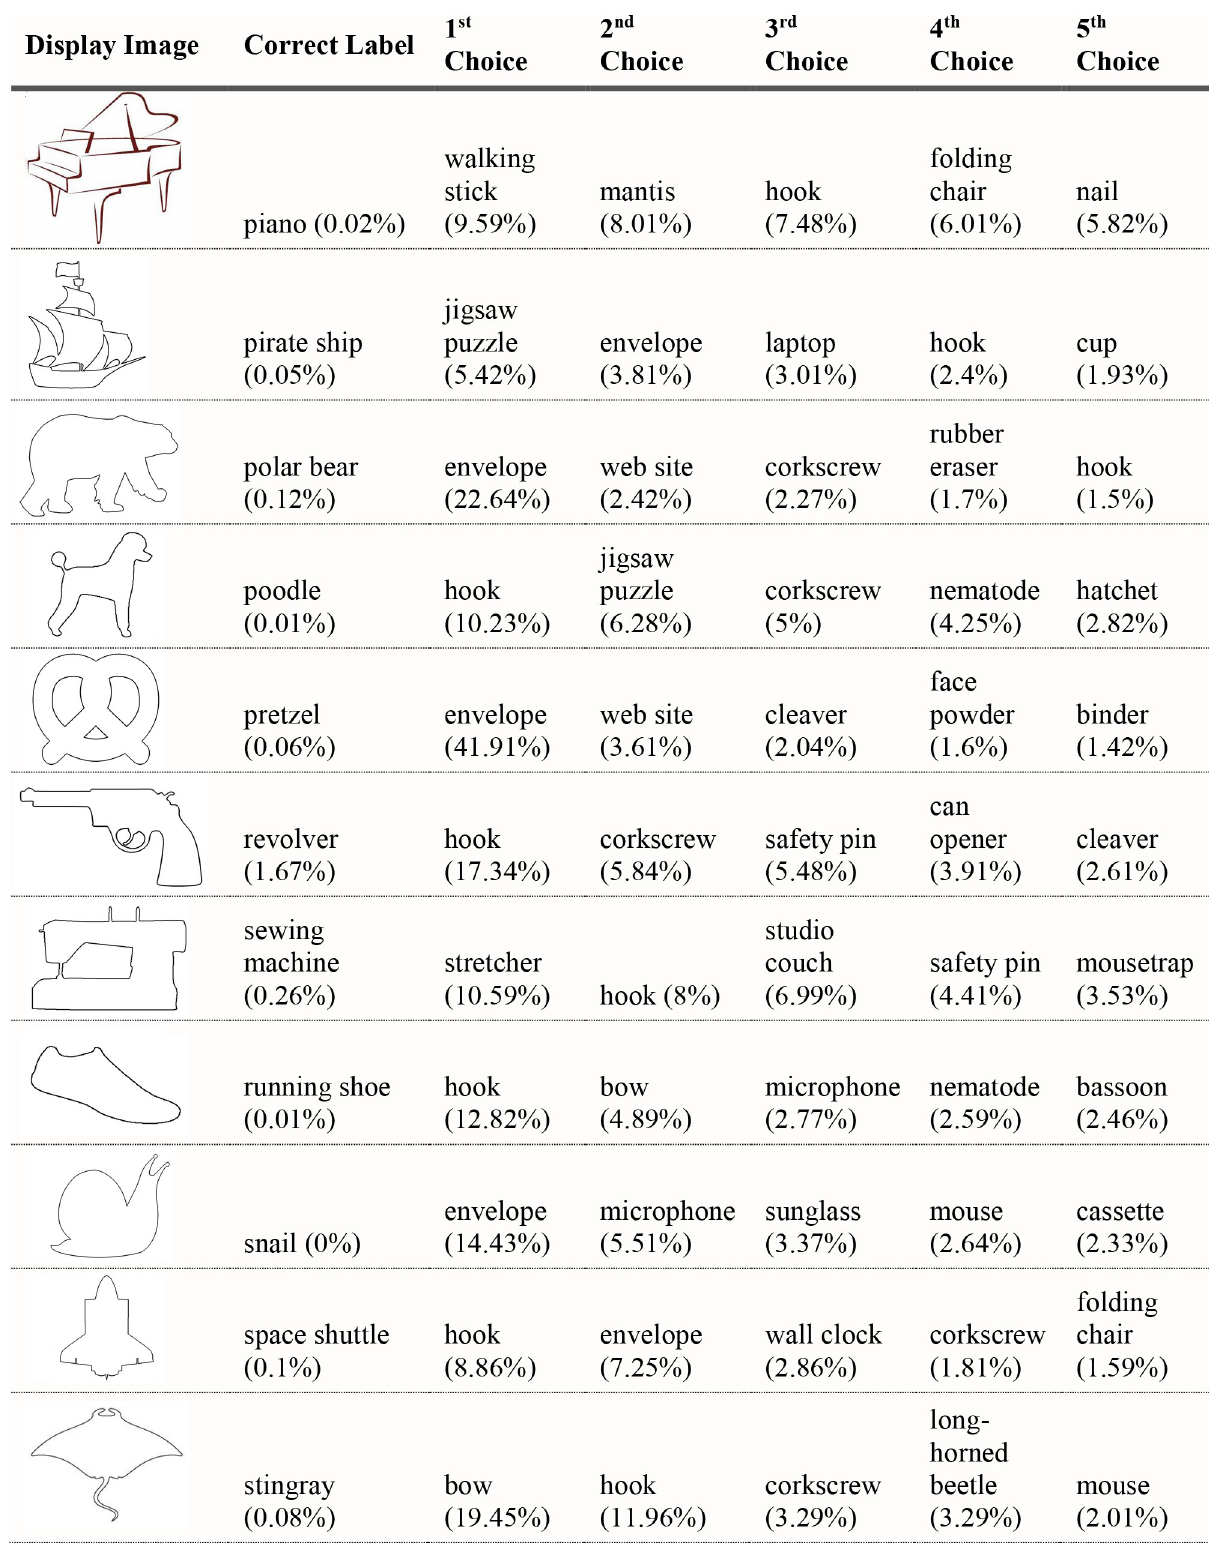
PLOS Computational Biology | https://doi.org/10.1371/journal.pcbi.1006613 December 7,